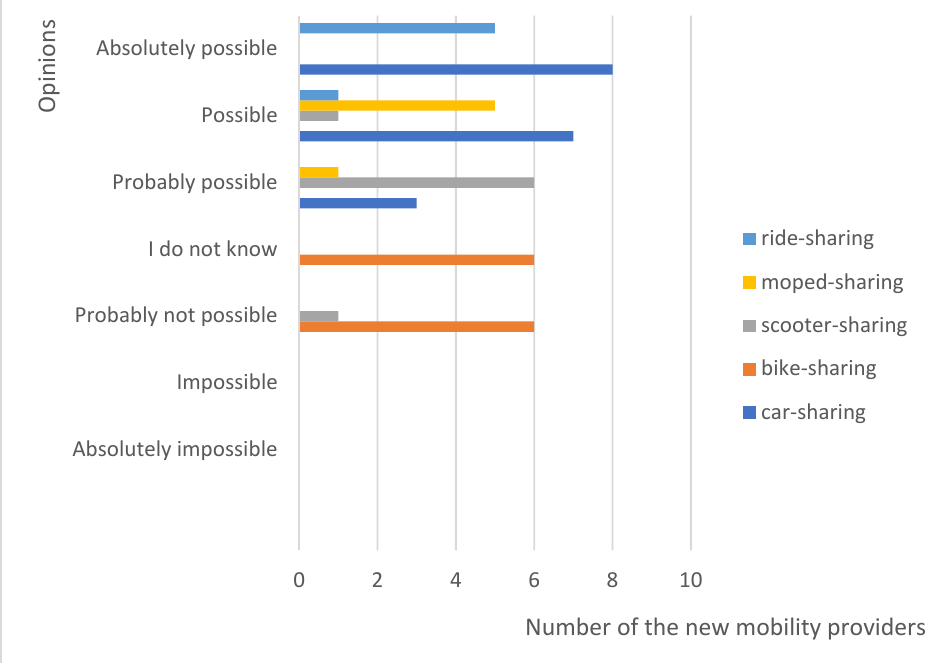
Figure 10. The possibility of the implemented practices remaining implemented in the new mobility market after the pandemic—detailed results broken down into new mobility sectors.